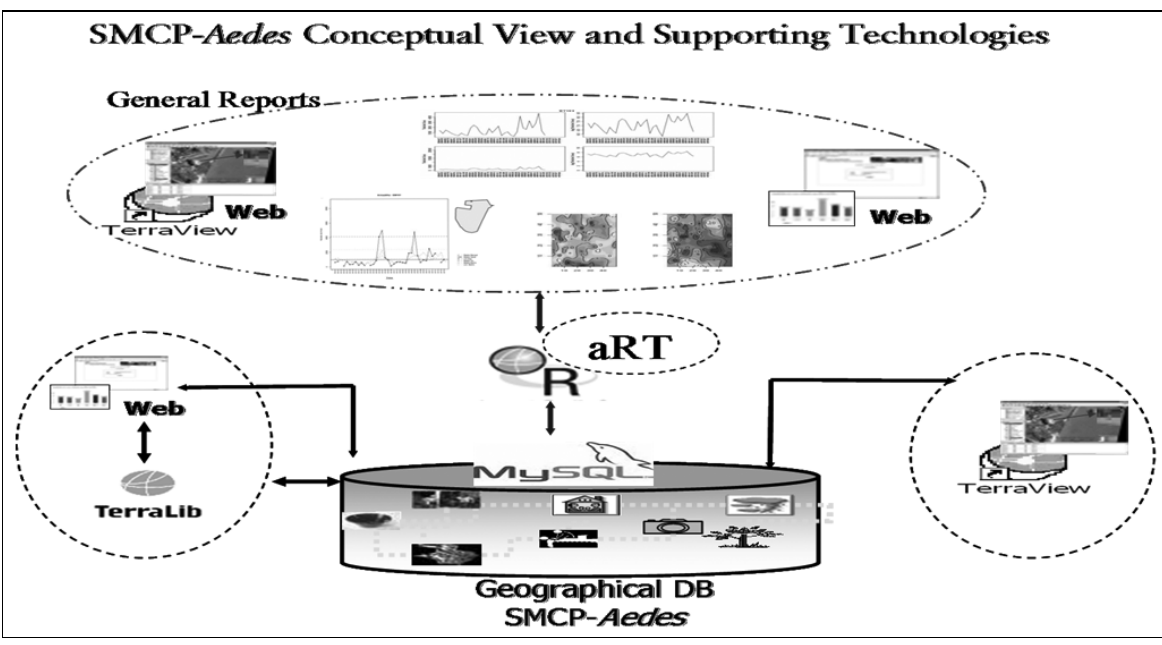
Fig. 2–AGeneralConceptualSchemefortheComputationalArchitectureoftheSMCP- Aedes includingtheopensetofspatialtechnologieschosen for implementation of the system. It involves open GIS library TerraLib, the open GIS application TerraView, the open database management system MySQL and the aRT – an Application Programming Interface for binding R to TerraLib running the RDengue statistical analysis